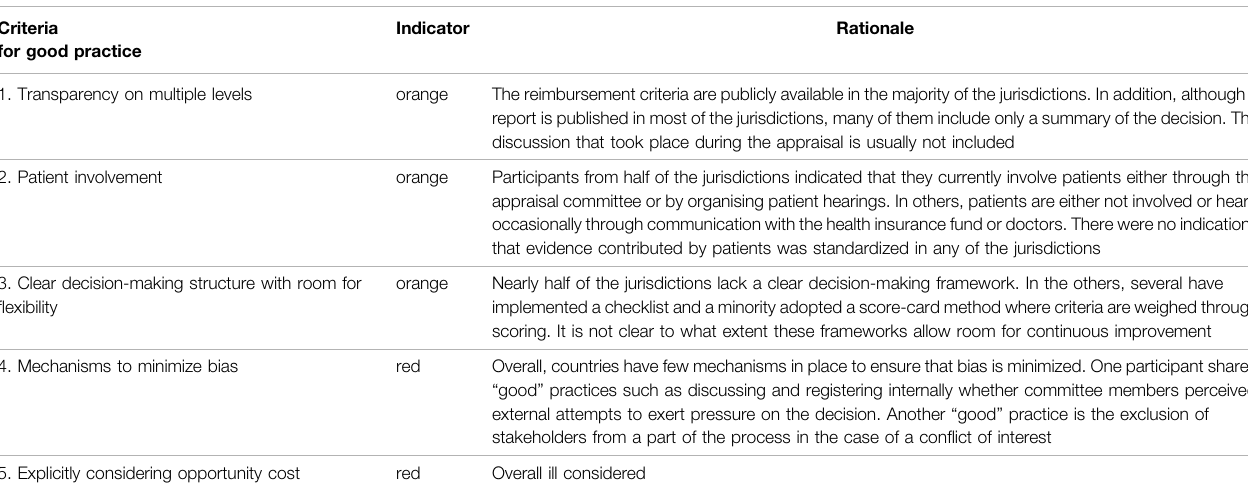
TABLE 5 | The overall performance of 19 European jurisdictions against fi ve criteria of good practice related to the reimbursement process of orphan drugs. Criteria for good